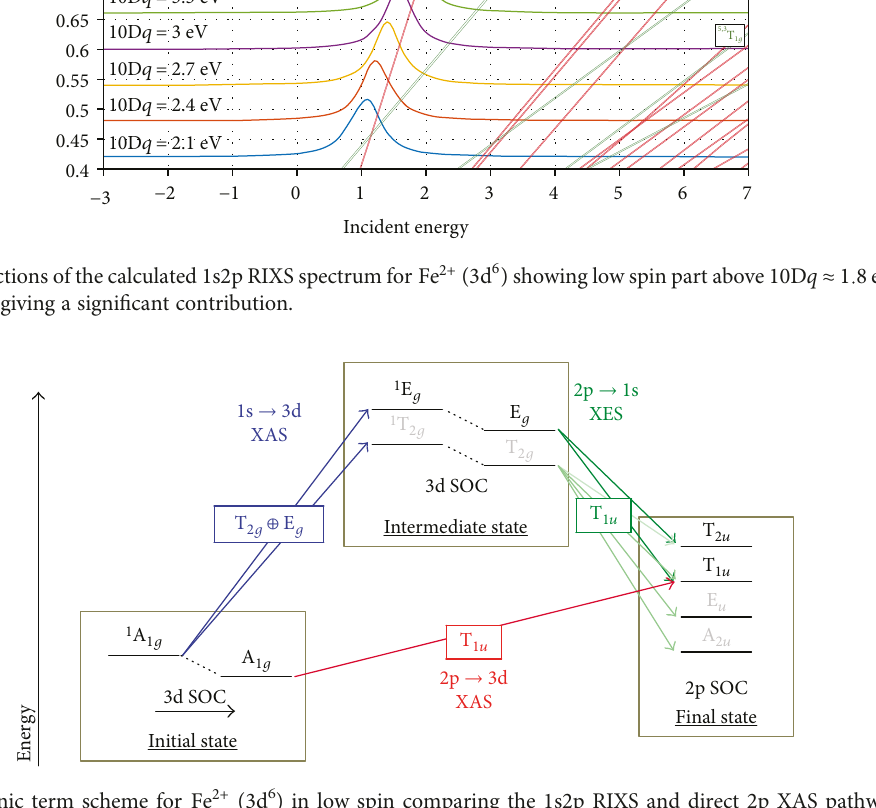
Figure 49: Multielectronic term scheme for Fe 2+ (3d 6 ) in low spin comparing the 1s2p RIXS and direct 2p XAS pathways. We note its similarity to the Ti 4+ (3d 0 ) case shown in Figure